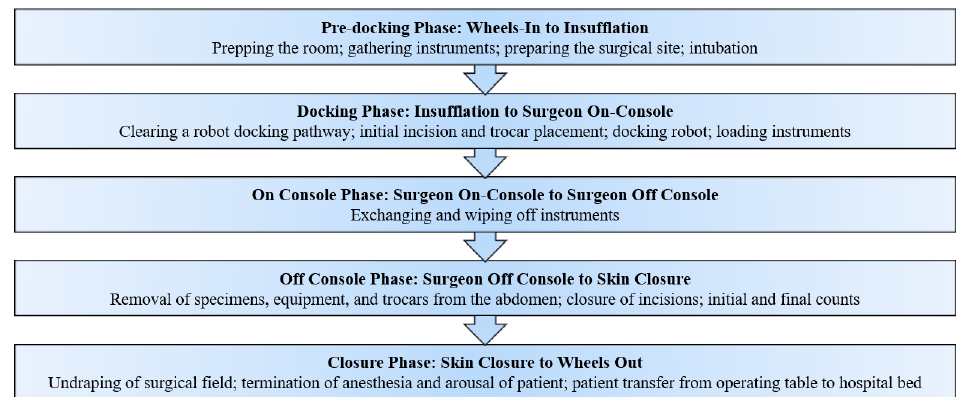
Figure 1. Tasks conducted by the OR team during RAS phases.